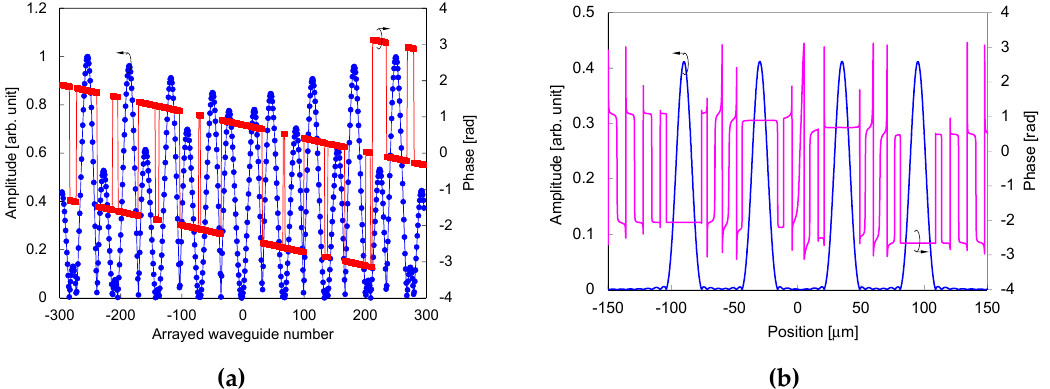
Figure 3. Design of waveguide array for spatial filtering. ( a ) Complex transmitting coefficient A i . ( b ) Resultant field distribution of focusing beams at edge of output slab from waveguide array.